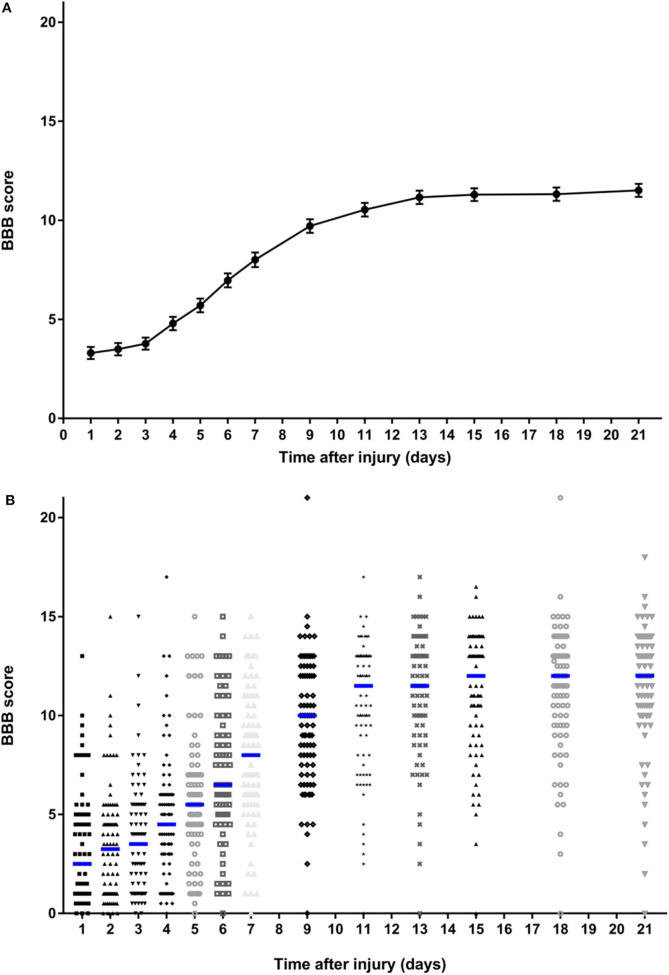
Summary data on BBB scores of all rats over the 21-day follow-up period following standardized 150 kdyne contusion injury at T12. (A) Points represent means and bars indicate standard error of the mean (s.e.m.) at each time point. (B) Dotplot showing score for rat at each time point; median at each time point is indicated by a blue bar.